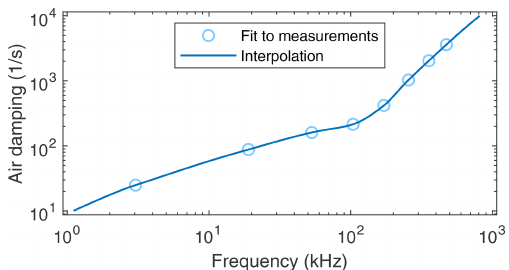
Figure 9. Frequency response of air damping, as determined by fitting the vibration model to resonance peaks of eight out-of-plane bending-vibration modes.